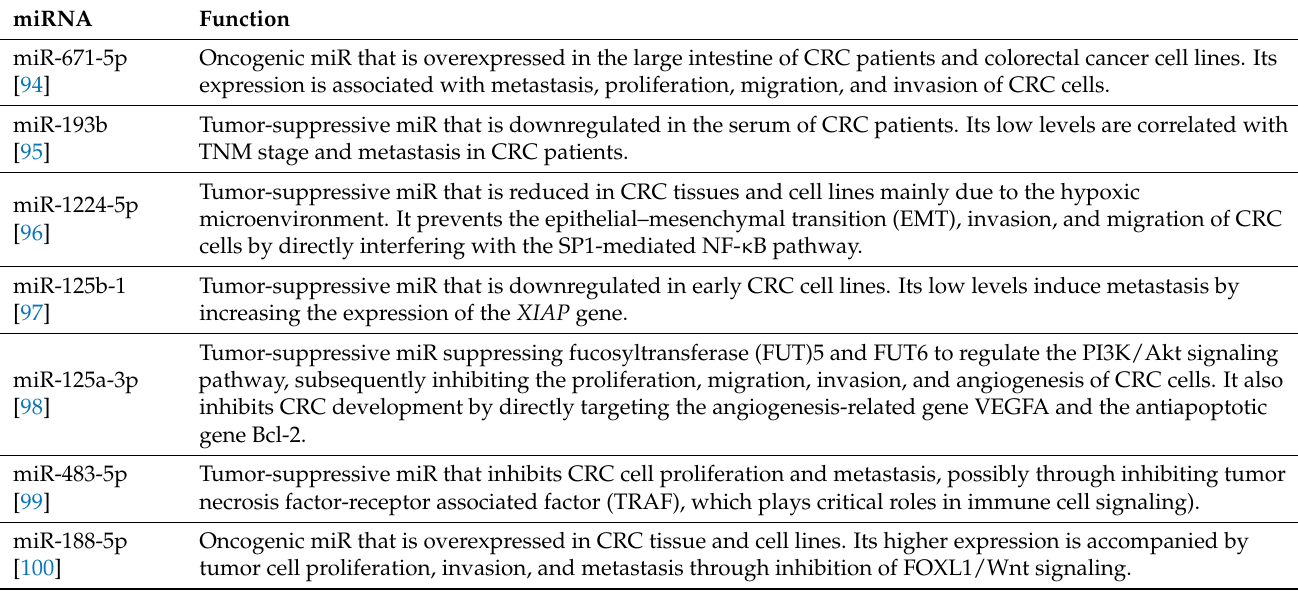
Table 1. miRNAs sorted into exosomes with known functions in